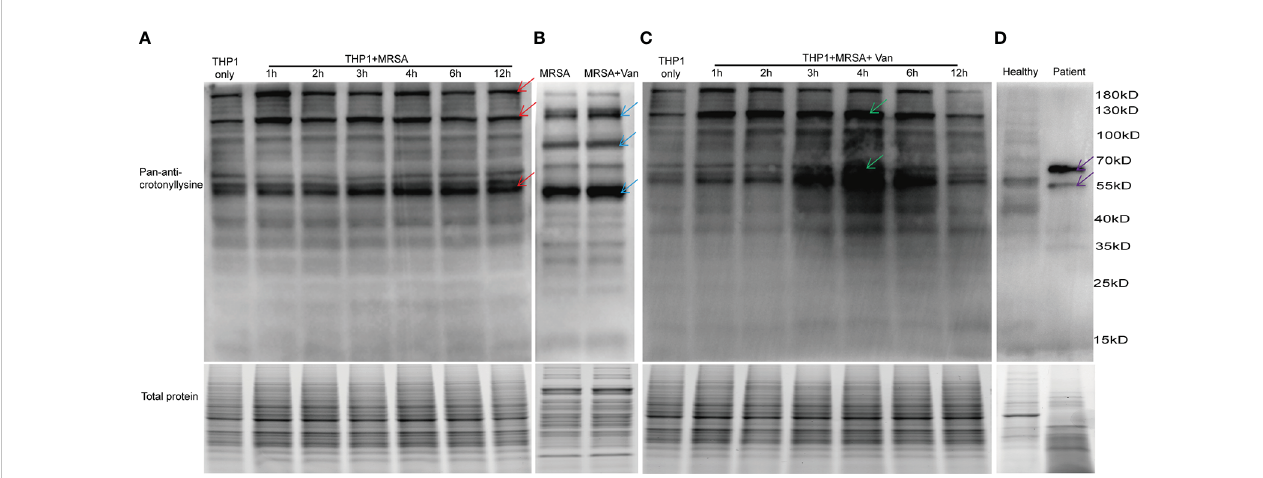
FIGURE 1 Detection of lysine crotonylation in THP1 cells, MRSA and PBMCs. Western blot analysis by pan-anti-crotonyllysine antibody. Lysates from (A) THP1 cells infected by MRSA for different times, and (B) MRSA and MRSA treated with vancomycin for 0.5 hours, (C) THP1 cells infected by MRSA for different times then treated with vancomycin for 0.5 hours, (D) PBMCs from healthy volunteer and MRSA-infected patients. The arrows show the elevated protein bands. Equal loading of total protein was veri fi ed using staining free